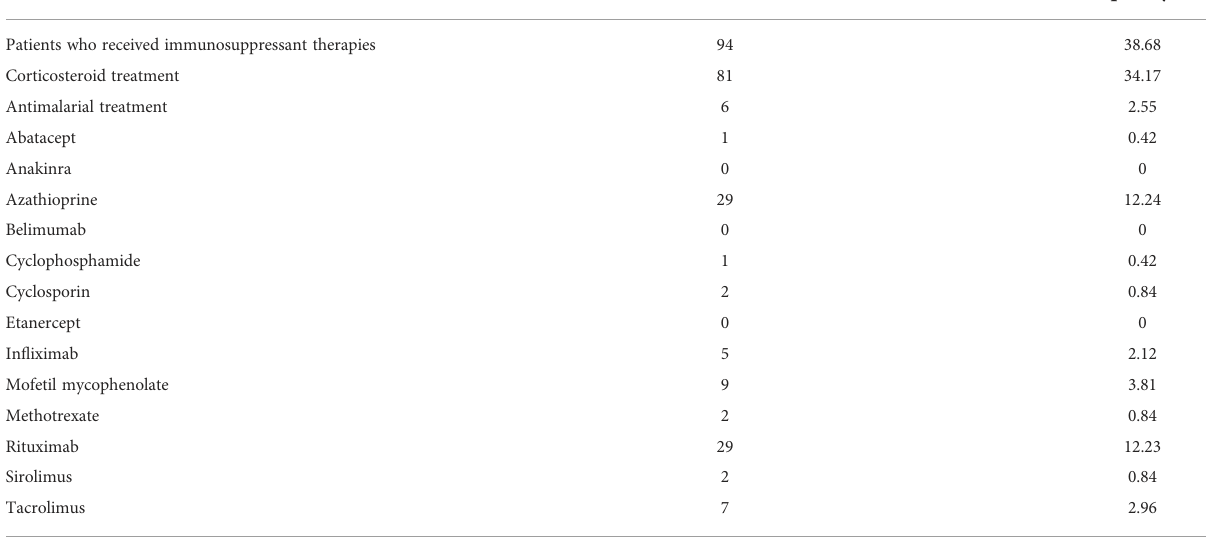
TABLE 3 History of immunosupressant treatment in the GTEM-SEMI-CVID